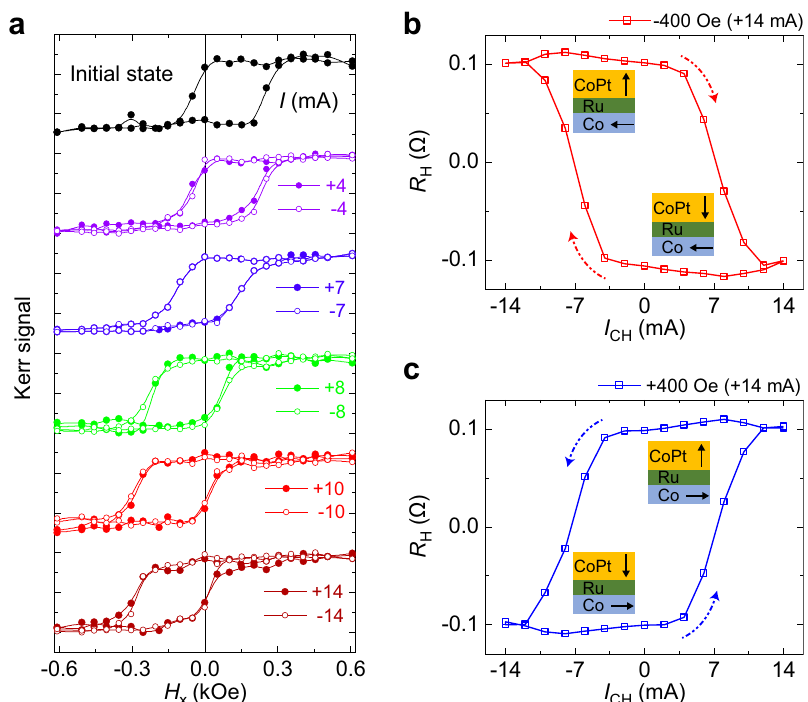
Fig. 5 Controllable switching polarity of the fi eld-free SOT switching. a In-plane hysteresis loops of the IrMn/Co/Ru/CoPt heterojunctions measured by magnetic optical Kerr effect. The initial state is set by applying a positive current pulse of þ 14mA under H single current pulse with various amplitude and direction under H x ¼ þ 400Oe. b The fi eld-free clockwise switching in the initial state. c The fi eld-free counterclockwise switching after reset by applying a positive current pulse of þ 14mA under H con fi guration of Co layer and CoPt